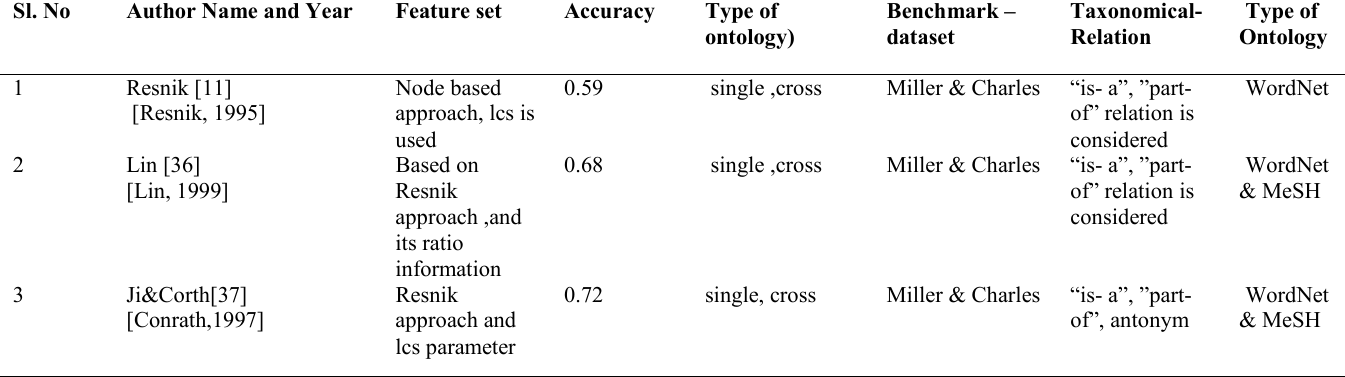
Table 3. Information content based Measures on various